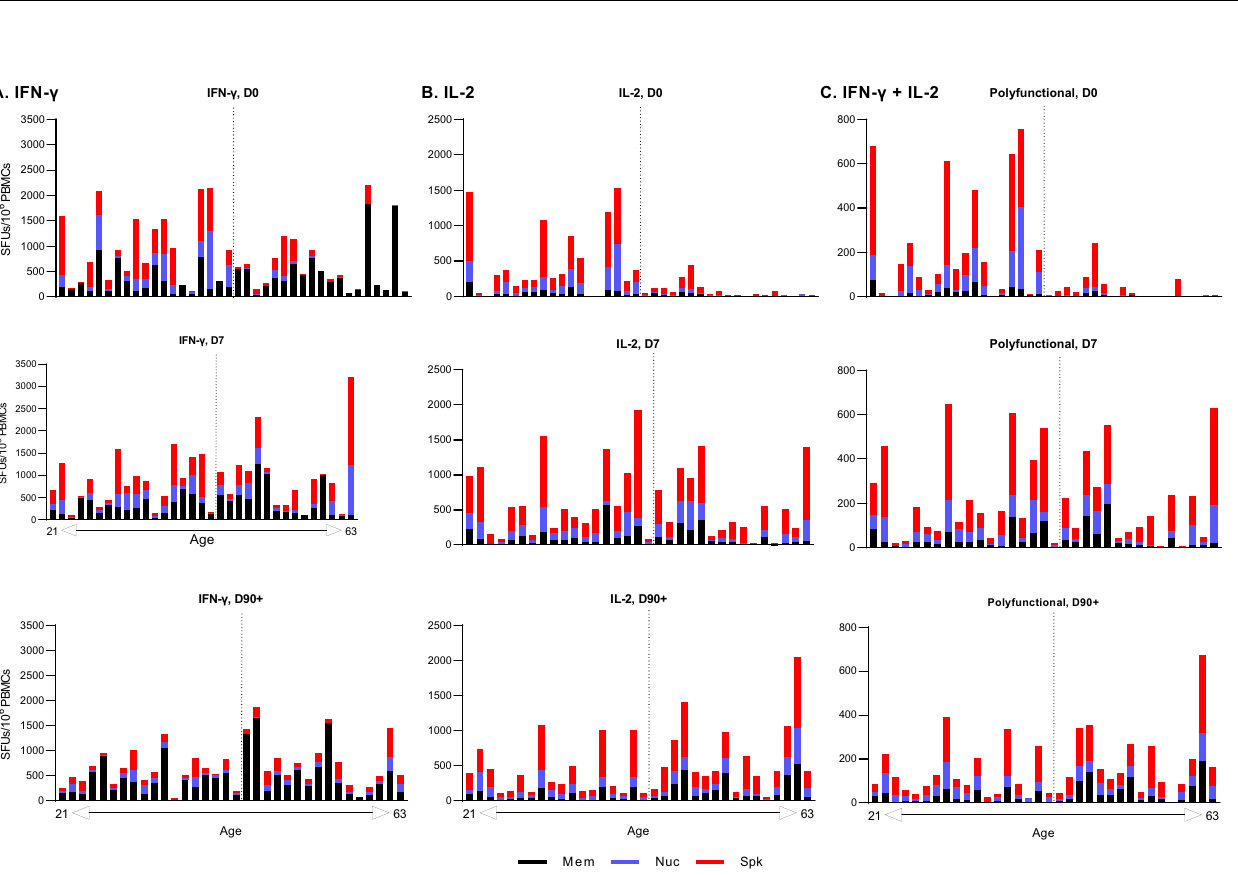
Fig. 6 | T cell responsesatday0, day7, and day90+in increasing orderofage. A IFN- γ B IL-2 C Polyfunctional (IFN- γ +IL-2) T cell responses (as SFUs per 10 6 PBMCs)againststructuralSARS-CoV-2proteinpeptide.Thedashedlinerepresents